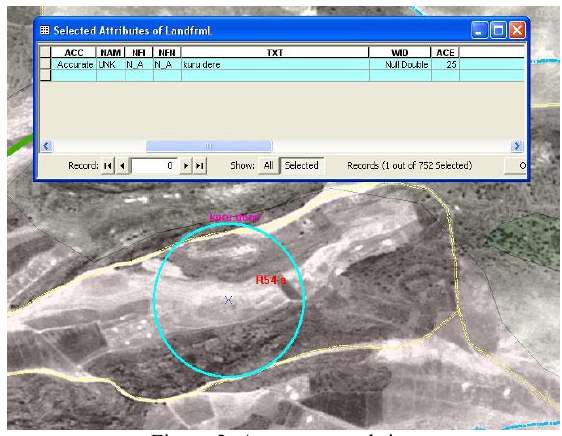
Figure 2. An uncaptured river